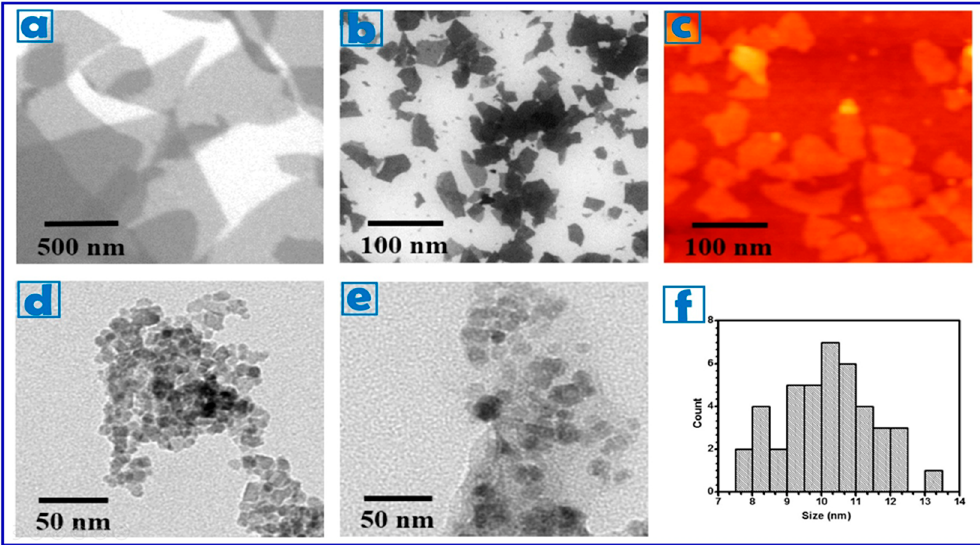
Figure 1. SEM images of ( a ) GO; and ( b ) NGO showing an average lateral width of 350–400 and 80–100 nm, respectively. ( c ) AFM image of NGO. TEM images of ( d ) γ -Fe 2 O 3 ; and ( e ) γ -Fe 2 O 3 @NGO nanoparticles. ( f ) Size distribution of γ -Fe 2 O 3 nanoparticles (approximately 10 nm).